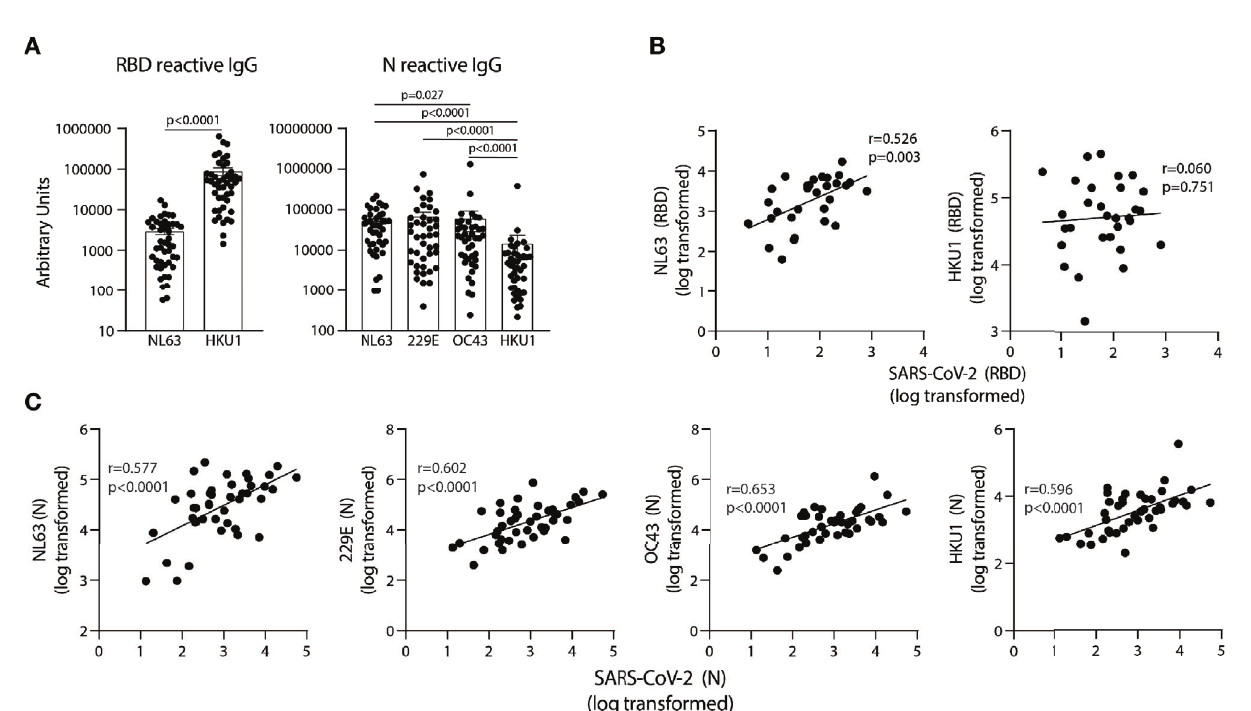
FIGURE 3 | SARS-CoV-2 RBD and N reactive IgG in pre-pandemic samples track with IgG recognizing analogous proteins of eCoV strains. (A) AUs of IgG reactive to RBD of NL63 and HKU1 and N of all four eCoV strains (NL63, 2293, OC43, and HKU1). (B) Correlation between SARS-CoV-2 RBD IgG levels with NL63, HKU1 RBD IgG levels in individual subjects. (C) Correlation between SARS-CoV-2 N IgG and NL63, 229E, OC43, and HKU1 N IgG levels, n=30-42. Values were log- transformed to obtain a parametric distribution. Statistical analyses were performed using Pearson ’ s correlation of normally distributed log transformed AU values in (B, C) and an unpaired non-parametric Mann-Whitney t-test in (A)